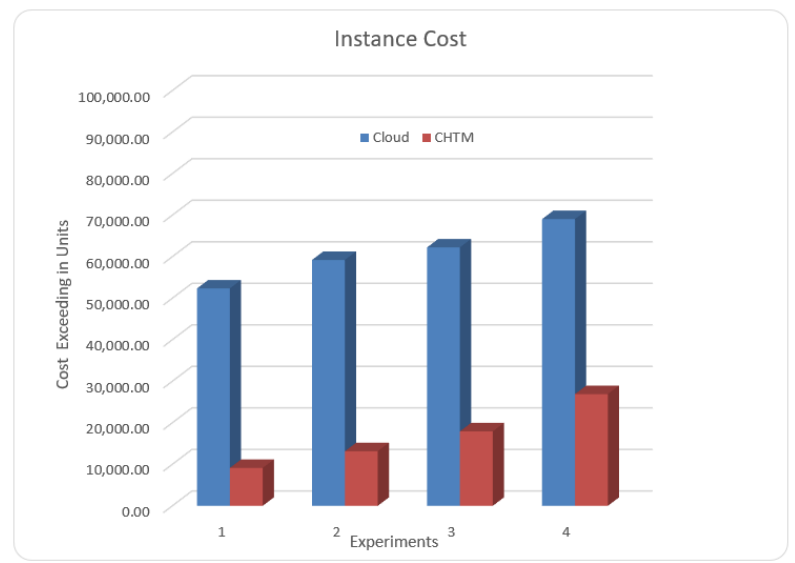
Figure 9. Average cost